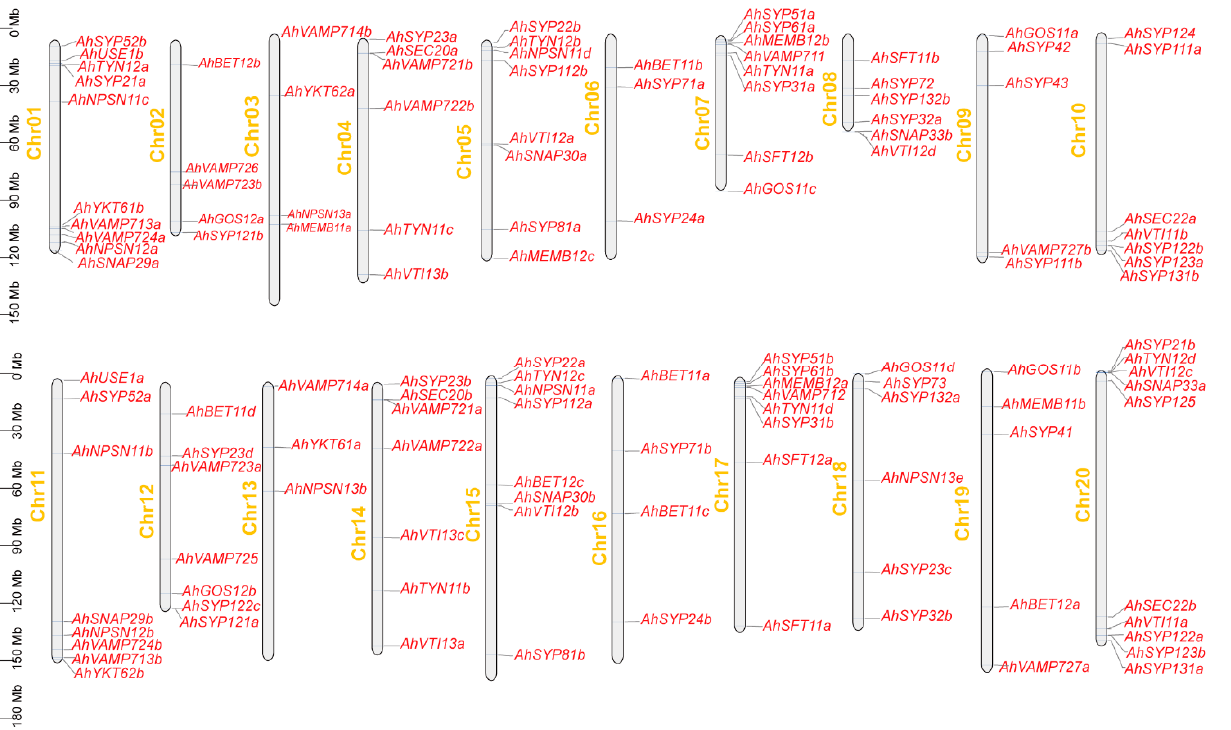
Figure 4. Chromosomal location and distribution of 129 AhSNARE genes. Chromosome size is indicated by relative length. Scale bar represents megabases (Mb). Physical locations of AhSNARE genes are indicated on each chromosome.